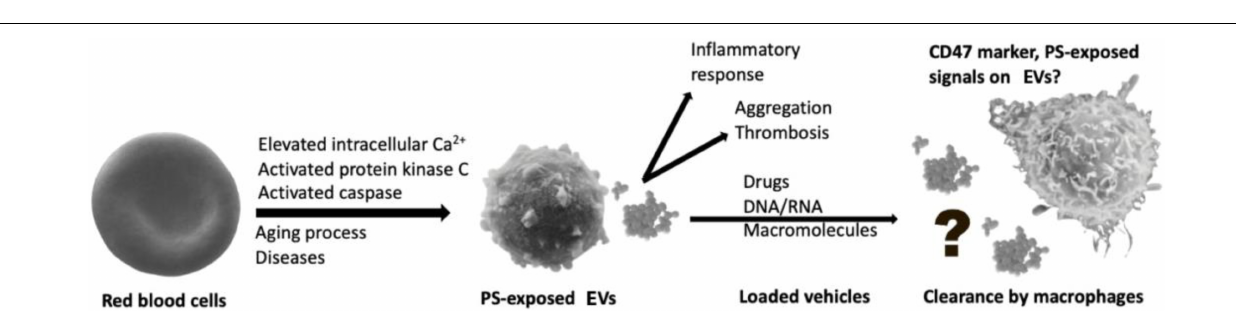
FIGURE 7 | Macrophages act as a barrier to recognize and eliminate red blood cell-derived extracellular vesicles